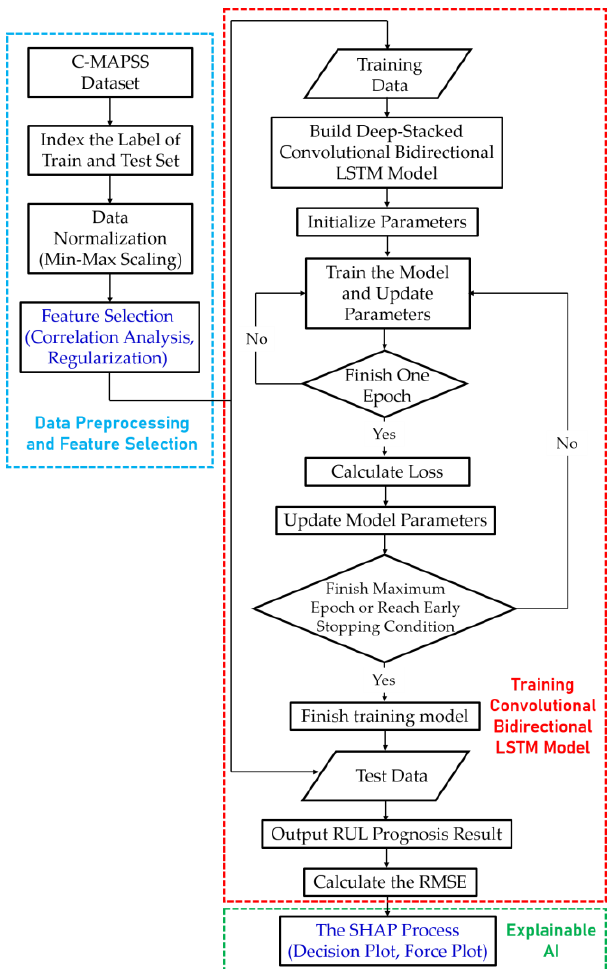
Figure 5. Flowchart of the experimental study.